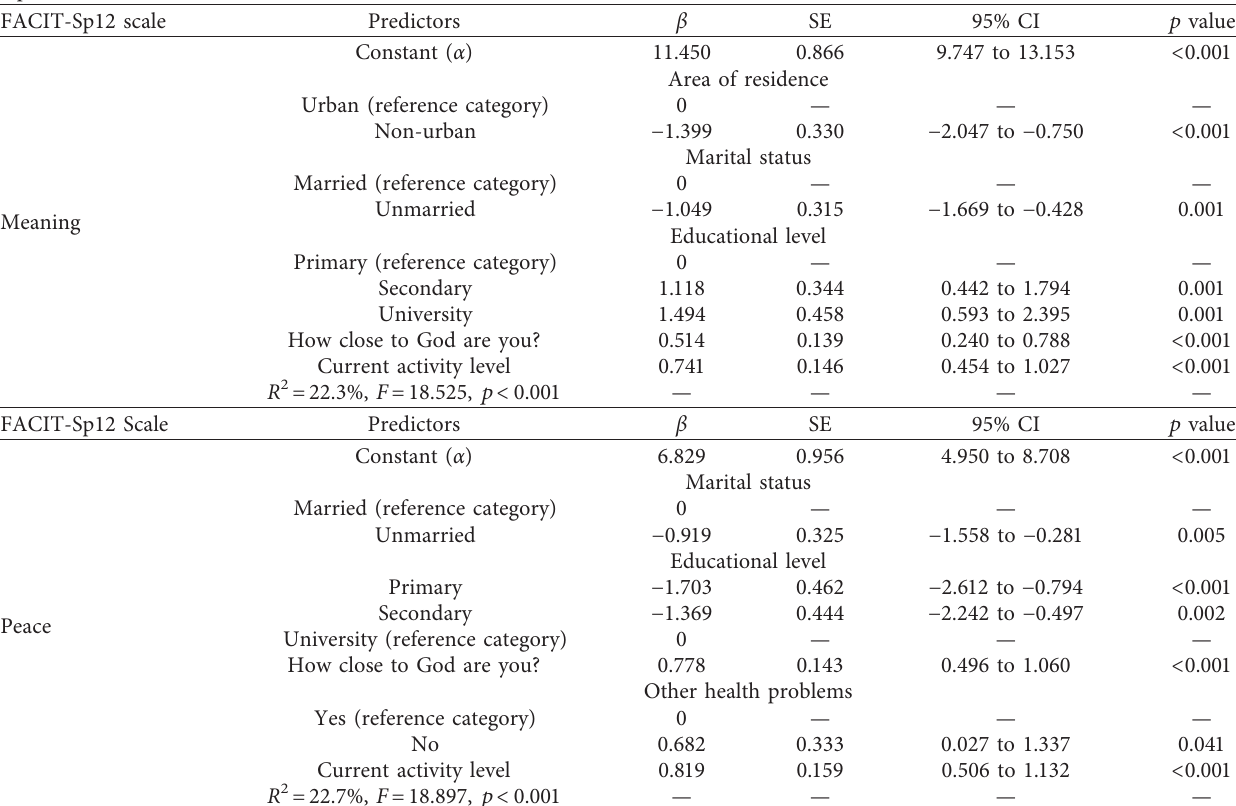
Table 3: Multiple linear regression (stepwise method) with FACIT-Sp12 Scale as a dependent value and patients characteristics as in- dependent variables ∗ ( n �